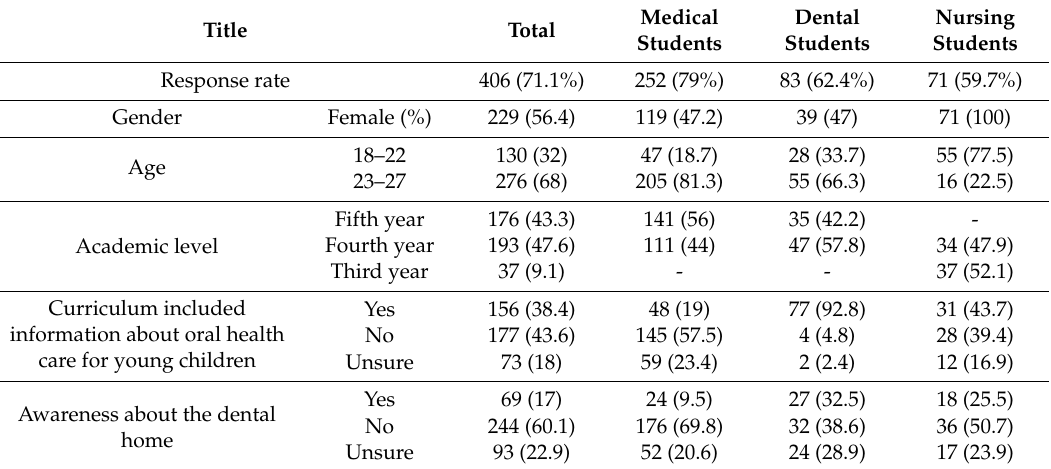
Table 1. Respondents’ characteristics ( n